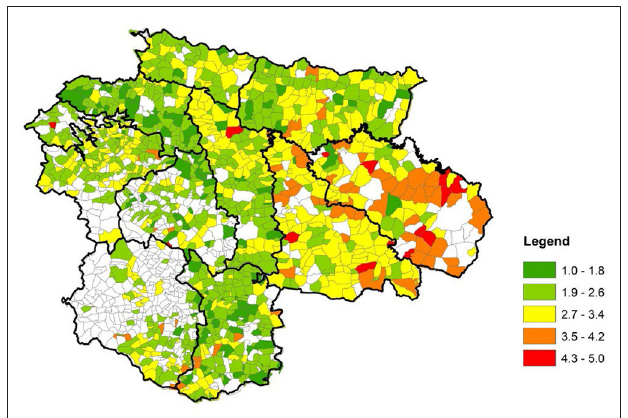
FIGURE 7 | Operations and maintenance financial